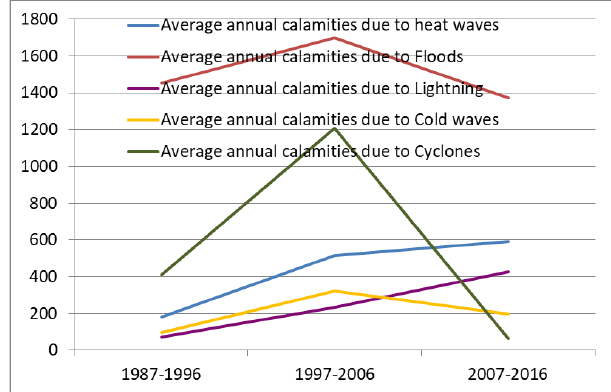
Figure 2. Average number of Deaths per year by Decade 1967- 2016(except due to cyclones)